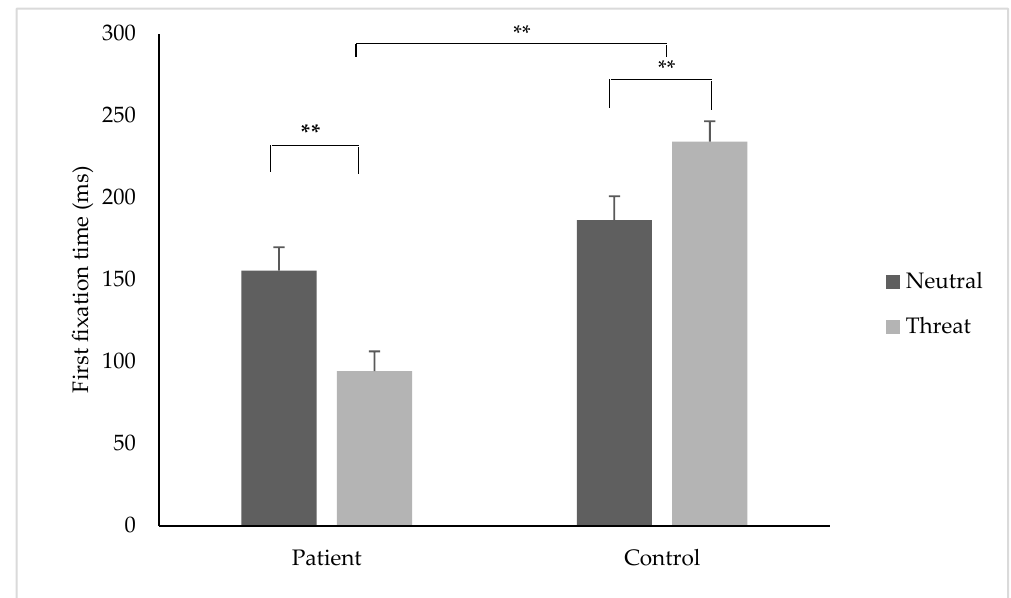
Figure 5. First fixation time (ms) ( ± SE) to threatening and neutral stimuli for the patient and control group. ** indicates p < 0.01.